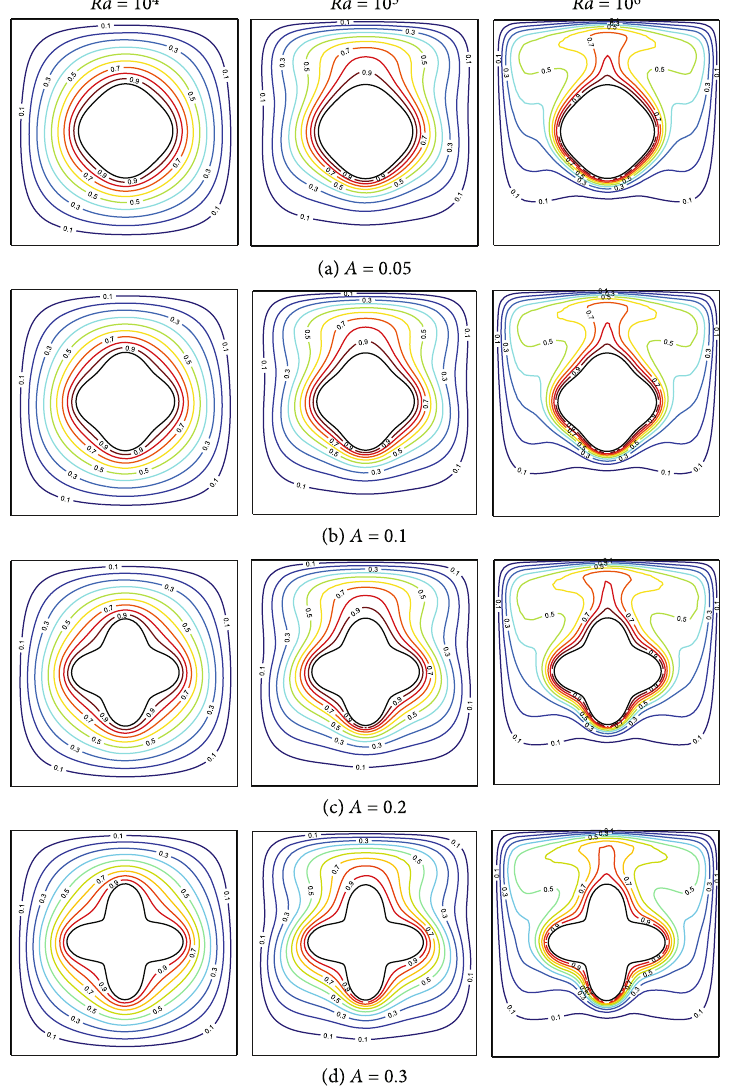
Figure 4: Isotherms for the combination of Rayleigh numbers and varying the amplitude corrugation, A at N = 4 and ϕ = 0 : 03